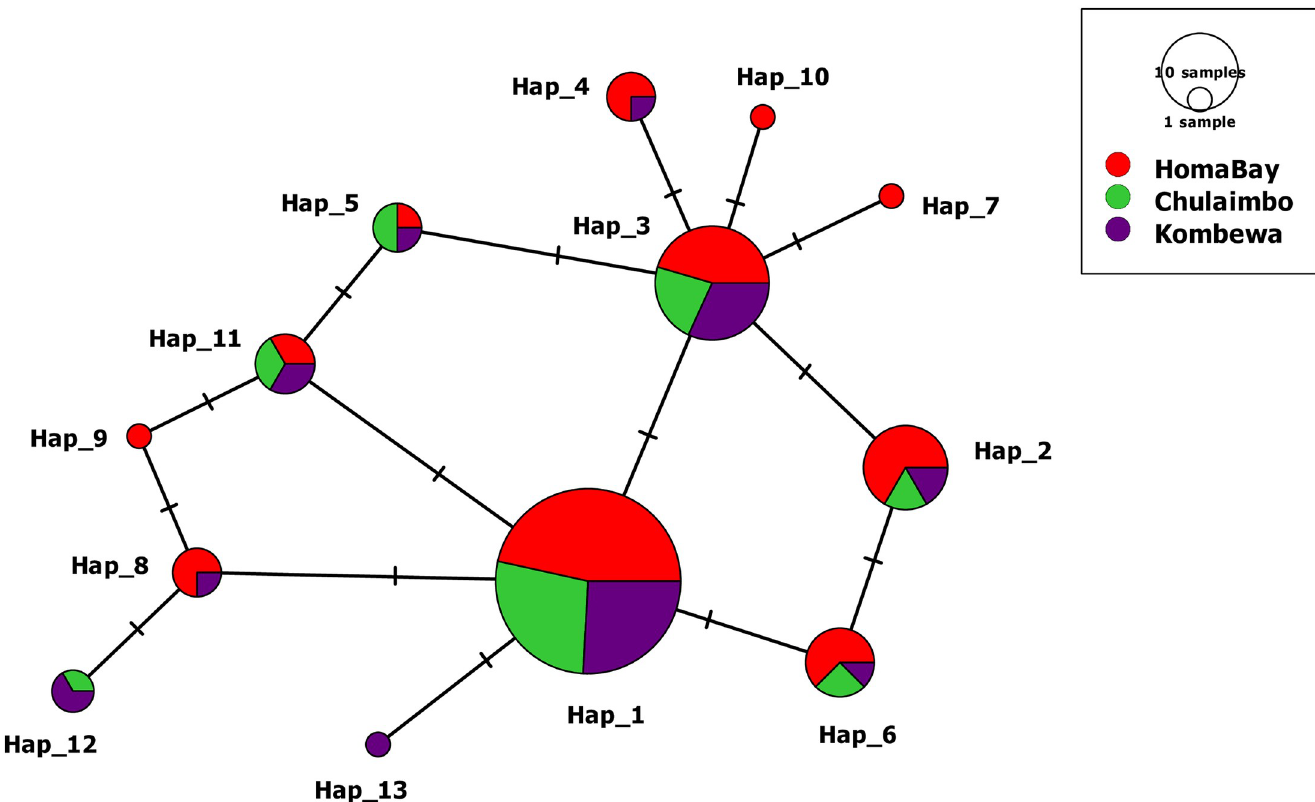
Fig 2. TCS-network of Pfs47 haplotypes showing all variants identified in Western Kenya regions (Hap_1-Hap_13). The size of the circle corresponds to haplotype frequency and the hatch mark represents the number of mutations observed. Colors represent circulating haplotypes identified in Homa Bay, Chulaimbo, and